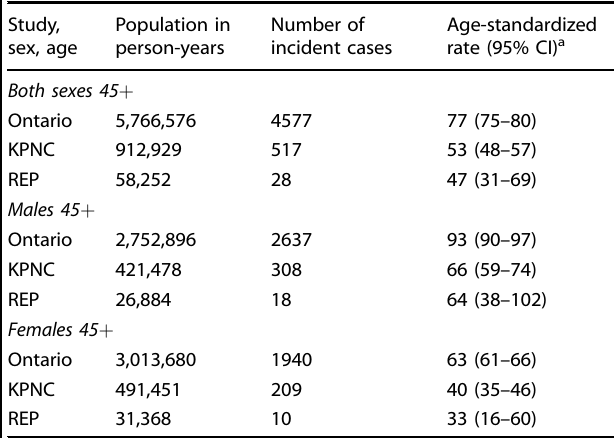
Table 2. Incidence of Parkinson disease by study, sex, among adults ages 45 and